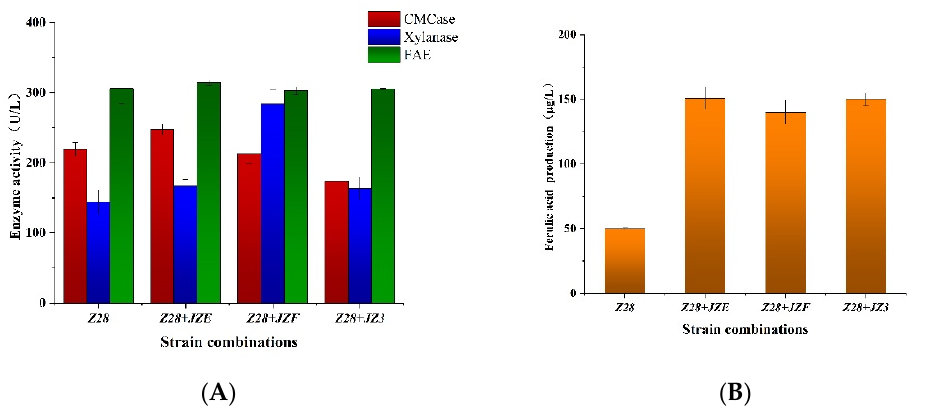
Figure 1. Analysis of enzyme activity ( A ) and FA production ( B ) during the combined culture of feruloyl esterase-producing strains andxylanase-producing strains. feruloyl esterase-producing strains andxylanase-producing